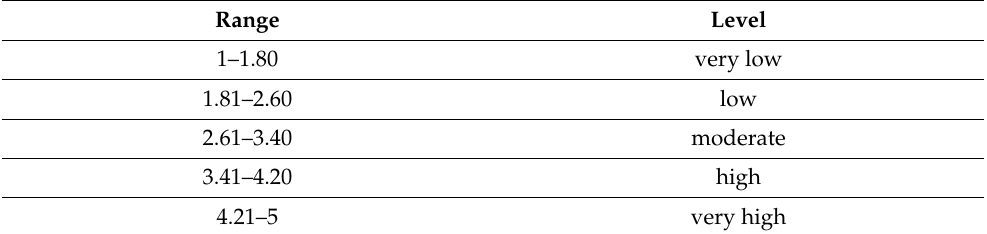
Table 2. Level lookup table of value and ranges.